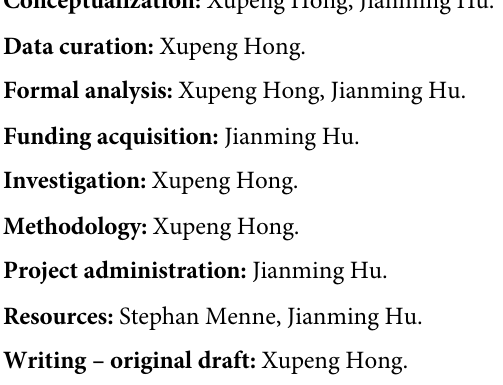
1.0. (D) core DNA was released from the NCs of cytoplasmic lysate by SDS-proteinase K treat- ment and detected by Southern blot analysis. (E) HBV PF-DNA was isolated from the trans- fected cells by the Hirt extraction method. The extracted DNA was treated with Dpn I plus Exo I & III to remove all DNA with free 3’ ends. (F) The cccDNA formation efficiency was cal- culated by normalizing the levels of cccDNA to those of rcDNA, with the efficiency from WT HBc set to 1.0. (G) Summary of all parameters of WHV replication in HepG2 and WCH-17 cells (shown in Fig 6 ). Increased parameters compared to HBc-WT were marked in red while decreased parameters compared to HBc-WT were marked in blue. Data is shown as mean ± SD. Two-tailed unpaired Student’s t test was used to compare the difference of each data set versus WT HBc ( � , p < 0.05; �� , p < 0.01; ��� , p < 0.001). Ca, capsid; pgRNA, prege- nomic RNA; HBc, HBV core protein; WHc, WHV core protein; ssDNA, single-strand DNA; rcDNA, relaxed circular DNA; cccDNA, covalently closed circular DNA; cM-DNA, closed minus strand DNA. S8 Fig. Effects of HBc or WHc on protecting the rcDNA content inside NCs. Core DNA released from the cytoplasmic lysate of WT or mutant HBc or WHc co-transfected with HBV-C(-) from WCH-17 cells (A) or with WHV-C(-) from HepG2 cells (B) , with or without prior Turbo DNase digestion, was detected by Southern blot analysis. The rcDNA signals obtained after Turbo DNase treatment is indicated by the dashed, red box for comparison to rcDNA signals present without nuclease treatment. ssDNA, single strand DNA; rcDNA, relaxed circular